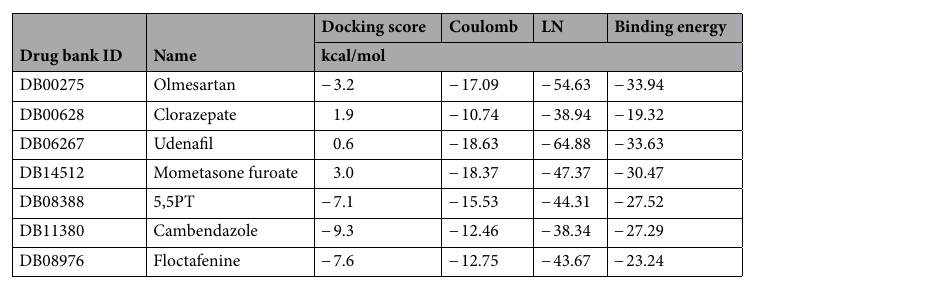
Table 4. Docking and molecular dynamic result of the Drug Bank Database